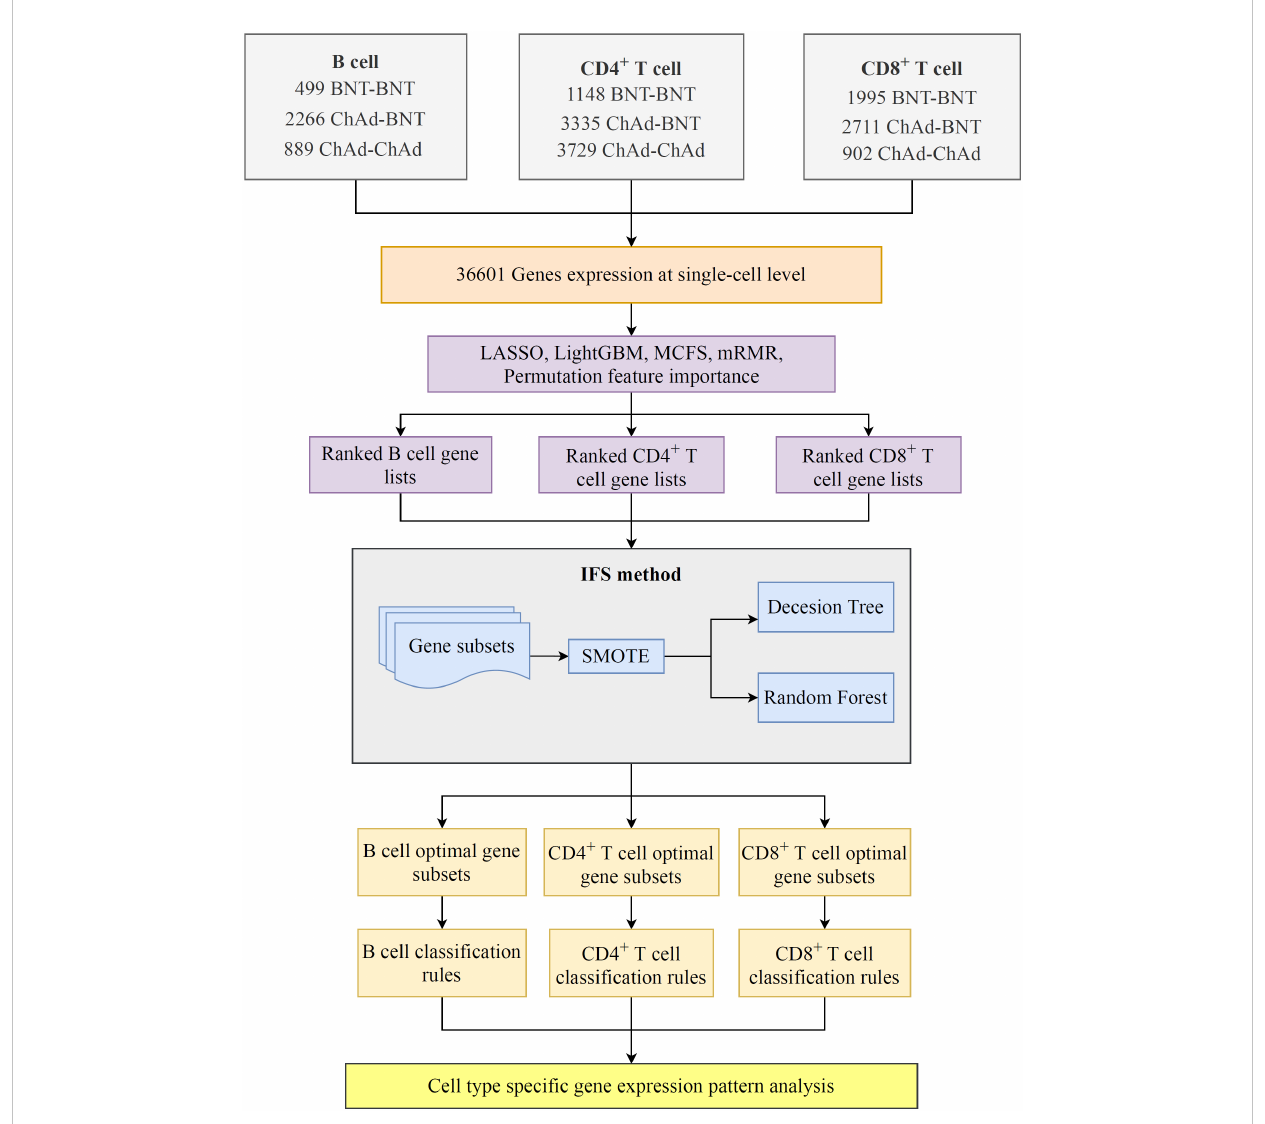
FIGURE 1 Flowchart of the computational framework that integrates multiple feature selection algorithms and classi fi cation algorithms. The single-cell pro fi les of COVID-19 includes B, CD4 + T, and CD8 + T cells, each of which has three vaccination states, namely, BNT – BNT, ChAd – BNT, and ChAd – ChAd. On each cell type, a set of gene lists were obtained using fi ve feature ranking algorithms: LASSO, LightGBM, mRMR, MCFS, and permutation feature importance (PFI). Subsequently, the optimal classi fi ers and the corresponding optimal feature subsets on each gene list were obtained using the incremental feature selection (IFS) method. Finally, the classi fi cation rules were mined by each optimal decision tree (DT) classi fi